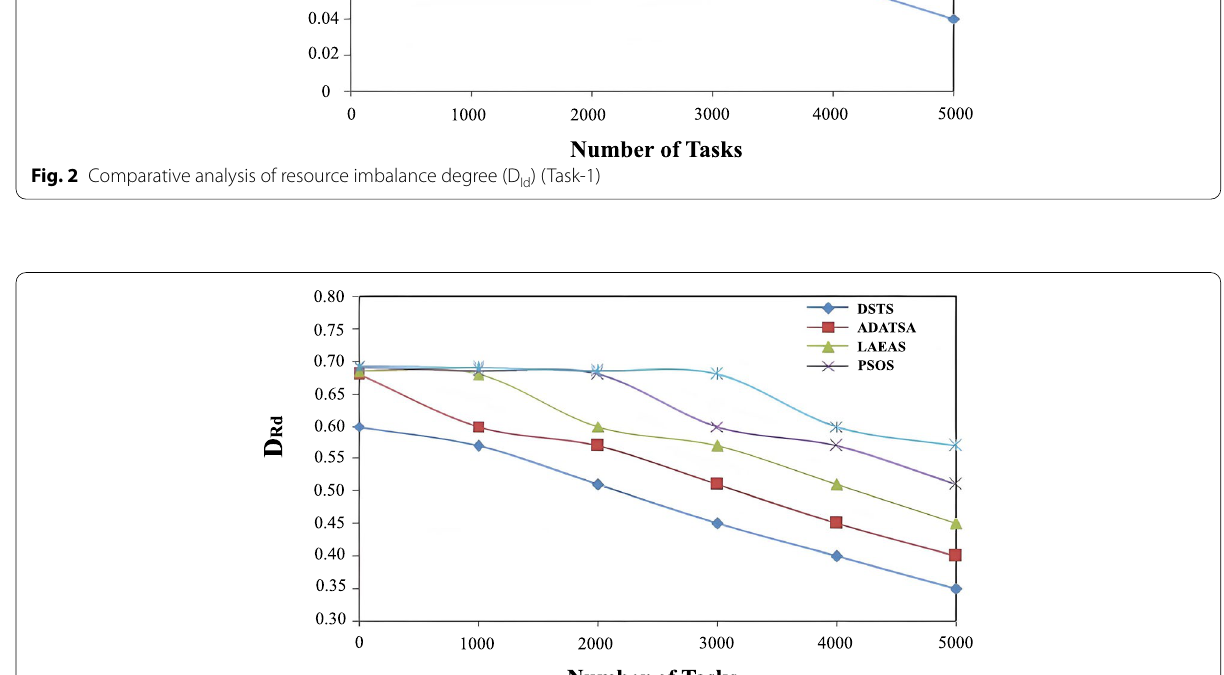
Fig. 3 Comparative analysis of resource residual degree (D Rd )